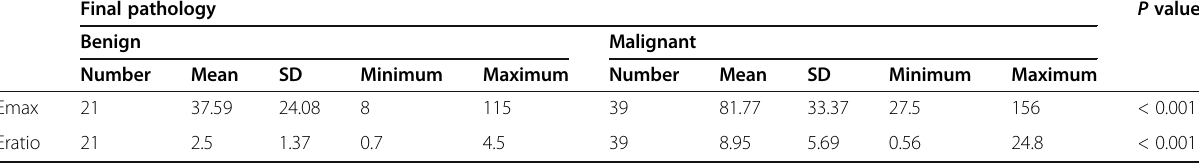
Table 3 Lymph node distribution according to Emax and Eratio values Final